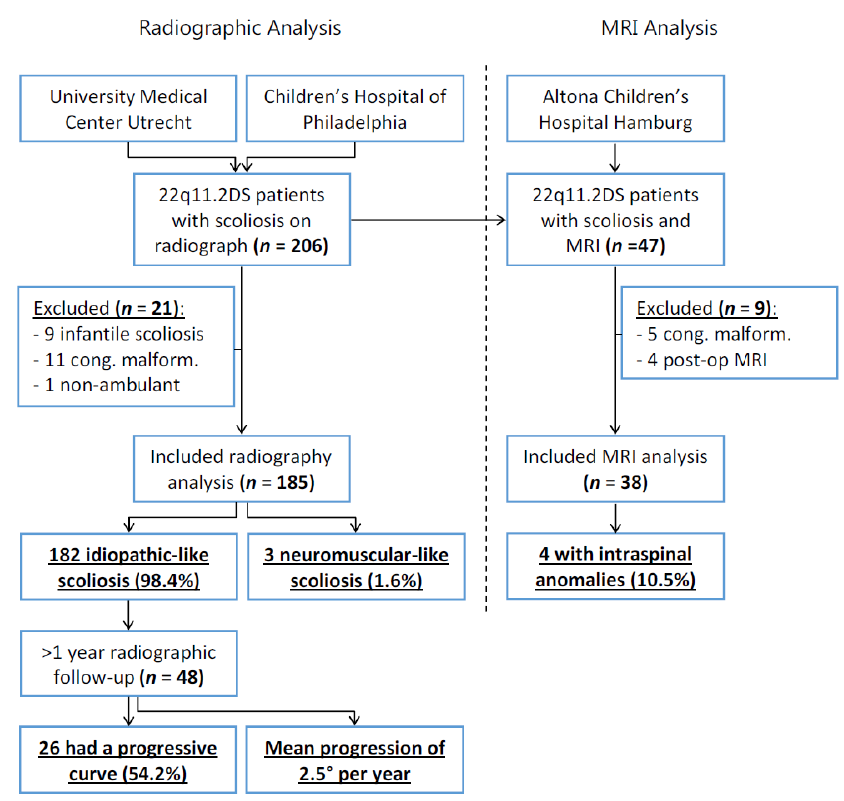
Figure 2. Flowchart shows the inclusion and exclusion of patients in the current study. Furthermore, the results of both the radiographic and MRI analysis are displayed.